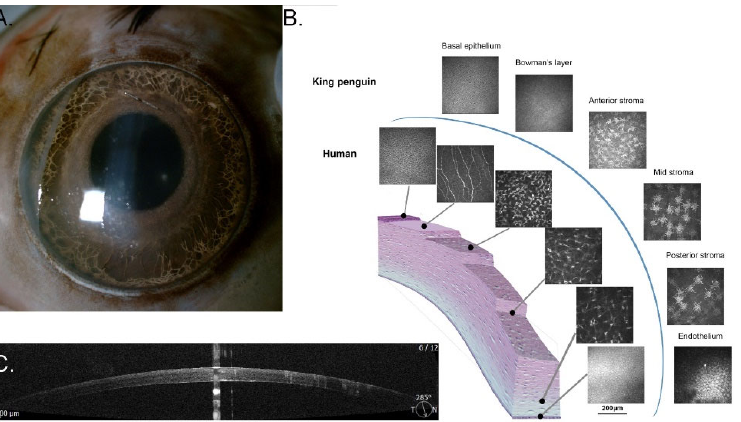
Figure 6. Cornea of the king penguin Aptenodytes patagonicus . ( A ) Immediate post ‐ mortem slit lamp photograph; note the transparent appearance and the translucent Membrana nictitans covering the cornea on the left-hand side (Credit: PWH); ( B ) Confocal micrographs of the king penguin cornea compared to those of the human (Heidelberg Retina Tomograph II Rostock Corneal Module, Heidelberg Engineering GmBH, Germany), which conforms to the description by Kafarnik et al. of other avian corneas. Note the absence of a subepithelial nerve plexus in Bowman’s layer; ( C ) Anterior segment optical coherence tomogram of the cornea (REVO NX, OPTOPOL Technology Sp. Z o.o., Zawierce, Poland). Credit: PWH.